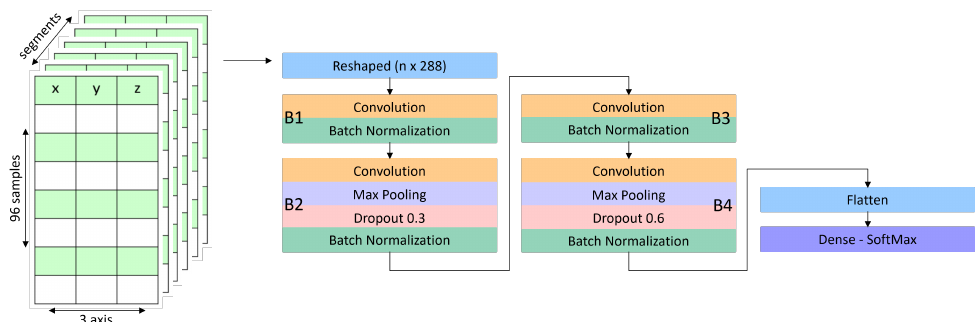
Figure 2. Convolutional Neural Network model architecture composed of an input layer, four blocks including multiple layers (B1, B2, B3, B4), flattening and ending softmax